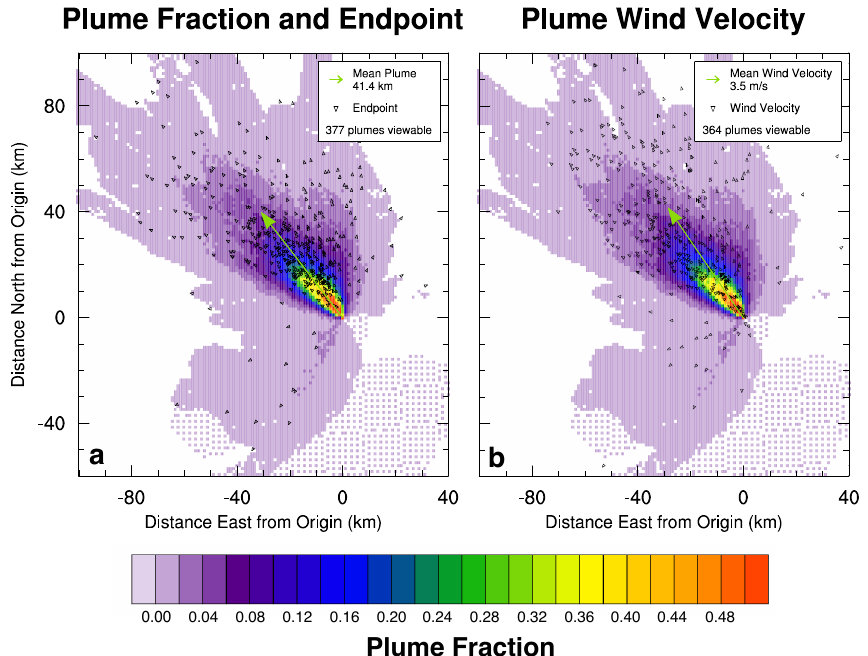
Fig. 2. Plume fraction (colors) overlaid with endpoints and wind velocities (triangles). (a) Triangles represent the most distant point of each plume transformed to lie on the origin-centroid axis. Green arrow shows mean plume length (41.4km). (b) Triangles represent the mean wind vector for each plume scaled so that the overall mean wind vector (3.5ms − 1 ), represented by the green arrow) is equal in length to the mean plume